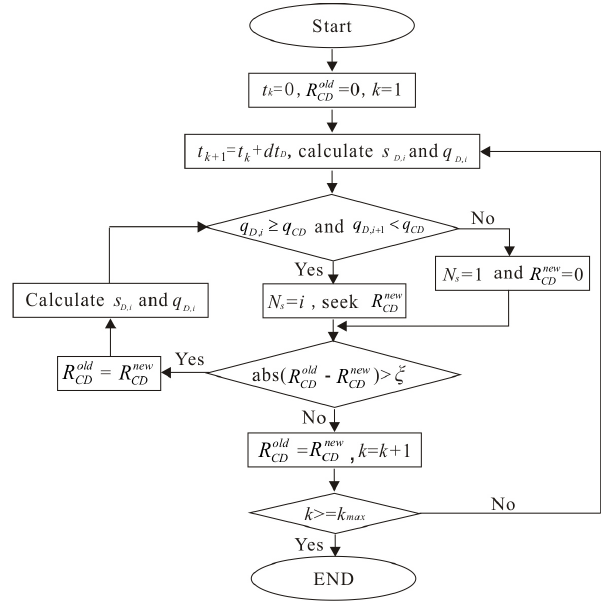
Figure 3. Flow chart of the MTRM